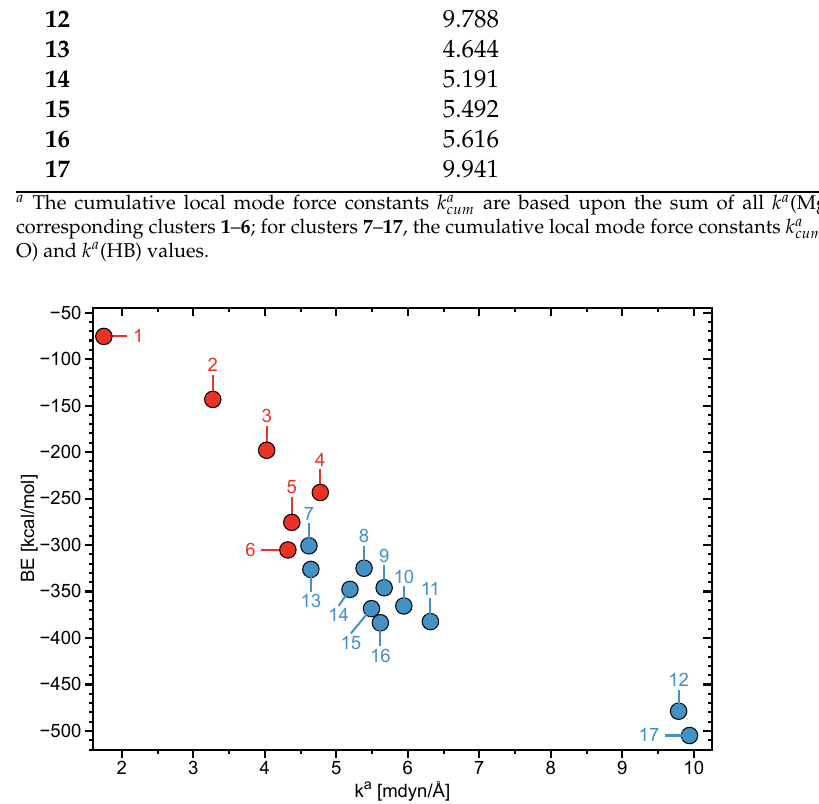
Figure 4. The binding energy (BE) and the corresponding cumulative local mode force constants k a cum of the clusters 1 – 17 calculated at the ω B97X-D/6-311++G(d,p) level of theory. Clusters 1 – 6 are represented by red points and clusters 7 – 17 are depicted by blue